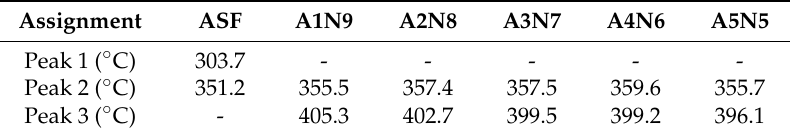
Figure 7. TGA curves for composite hydrogels prepared by different ASF content. Table 3. TGA date of composite hydrogels.